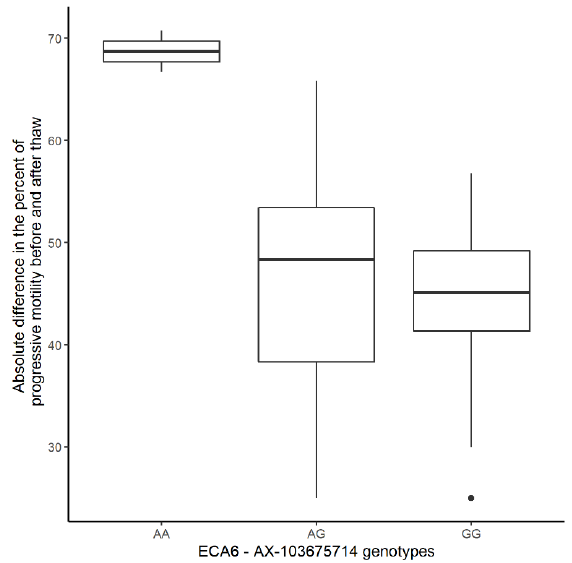
Figure 2. Absolute difference in mean progressive motility between fresh and frozen-thawed semen dependent on the genotype of the best-associated SNP on ECA6, AX-103675714.